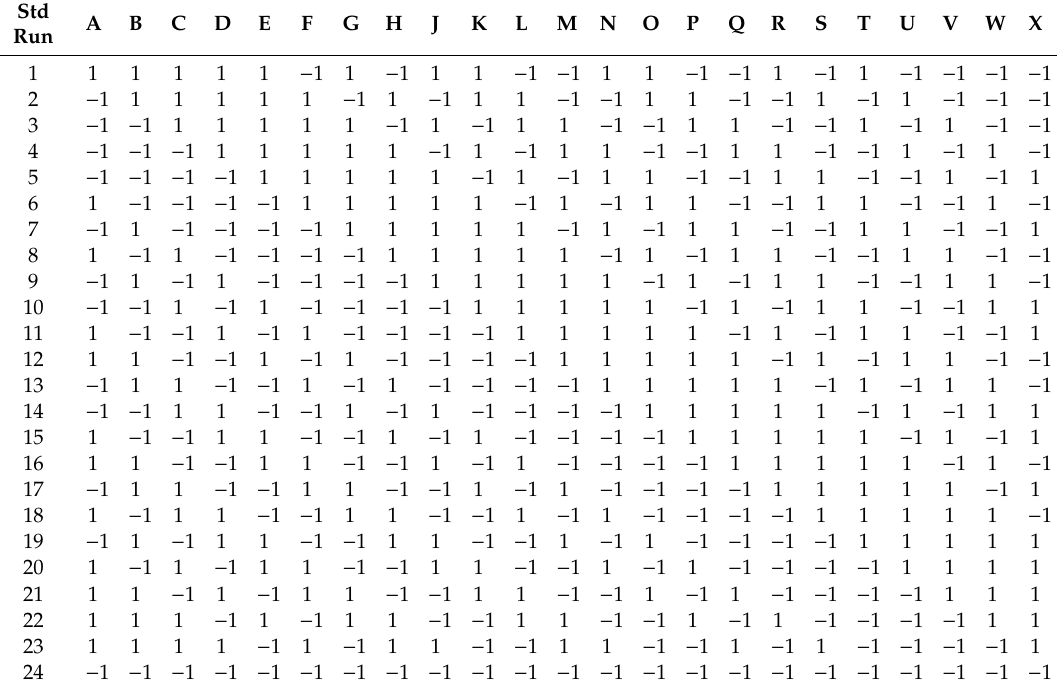
Table 10. PBD matrix for 22 variables with coded values for tryptophan production by P. acidilactici TP-6. Std